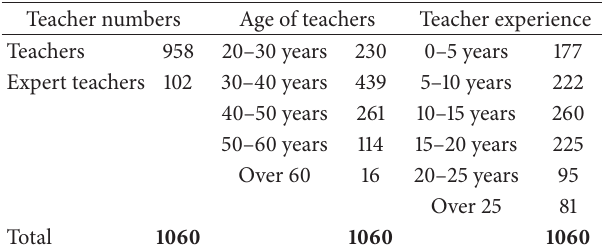
Table 1: The number, the length of experience, and the age of